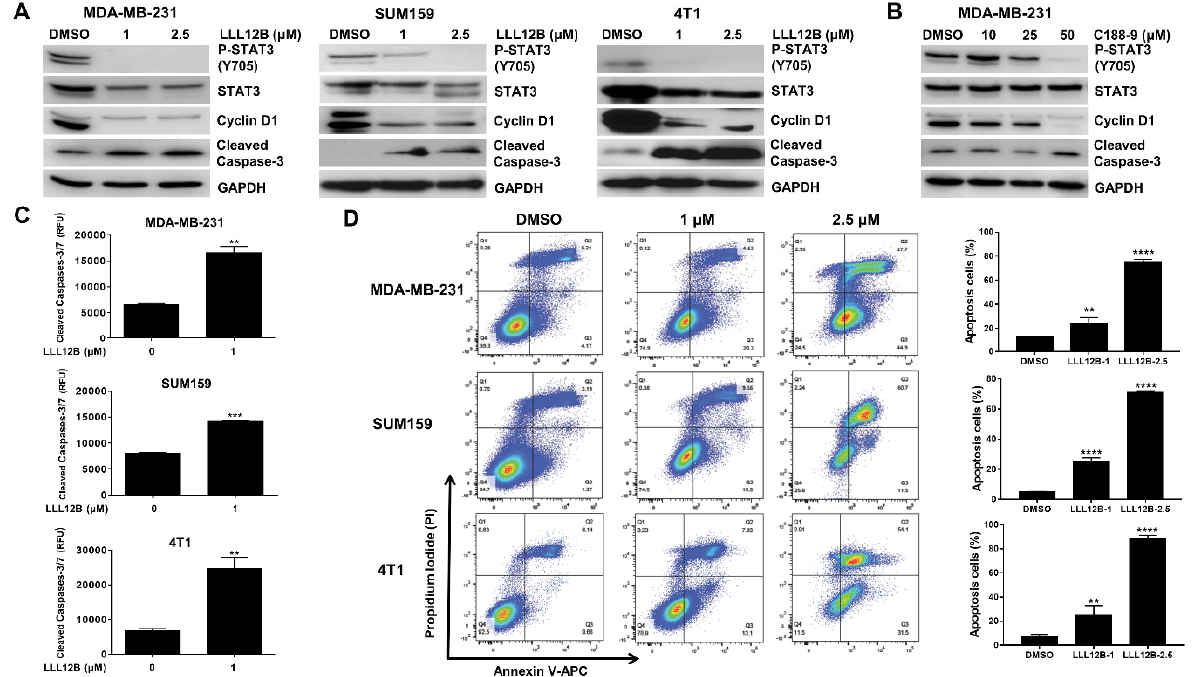
Figure 3. LLL12B inhibited STAT3 phosphorylation and induced apoptosis in TNBC cells. ( A ) MDA- MB-231, SUM159, and 4T1 cell lines were treated with DMSO or LLL12B overnight and the expres- sion levels of P-STAT3 (Y705), STAT3, cyclin D1, and cleaved caspase-3 were analyzed by Western blot analysis. GAPDH served as a protein loading control. ( B ) MDA-MB-231 cells were treated with DMSO or C188-9 overnight and the expression levels of P-STAT3 (Y705), STAT3, cyclin D1, and cleaved caspase-3 were analyzed by Western blot analysis. ( C ) MDA-MB-231, SUM159, and 4T1 cells were seeded in a 96-well plate and treated with DMSO or LLL12B for 5 h and a Caspase-3/7 Fluorescence Assay Kit was used to detect the activation of caspase-3/7. ( D ) MDA-MB-231, SUM159, and 4T1 cell lines were treated with DMSO or LLL12B for 8–12 h, and flow cytometry was performed to analyze annexin V and PI staining. The quantification of apoptotic cells was shown in the right panel. ** p < 0.01, *** p < 0.001 and **** p < 0.0001. 3.4. LLL12B Inhibits Colony Formation in the TNBC Cells To investigate the long-term effect of LLL12B on the expansion of TNBC cells, the colony formation assay was performed. MDA-MB-231, SUM159, and 4T1 cells were treated with LLL12B or DMSO for 24 h and recovered in a drug-free culture medium for 7 days. As shown in Figure 4, the LLL12B treatment showed a significant reduction in colony numbers compared to the DMSO treatment.